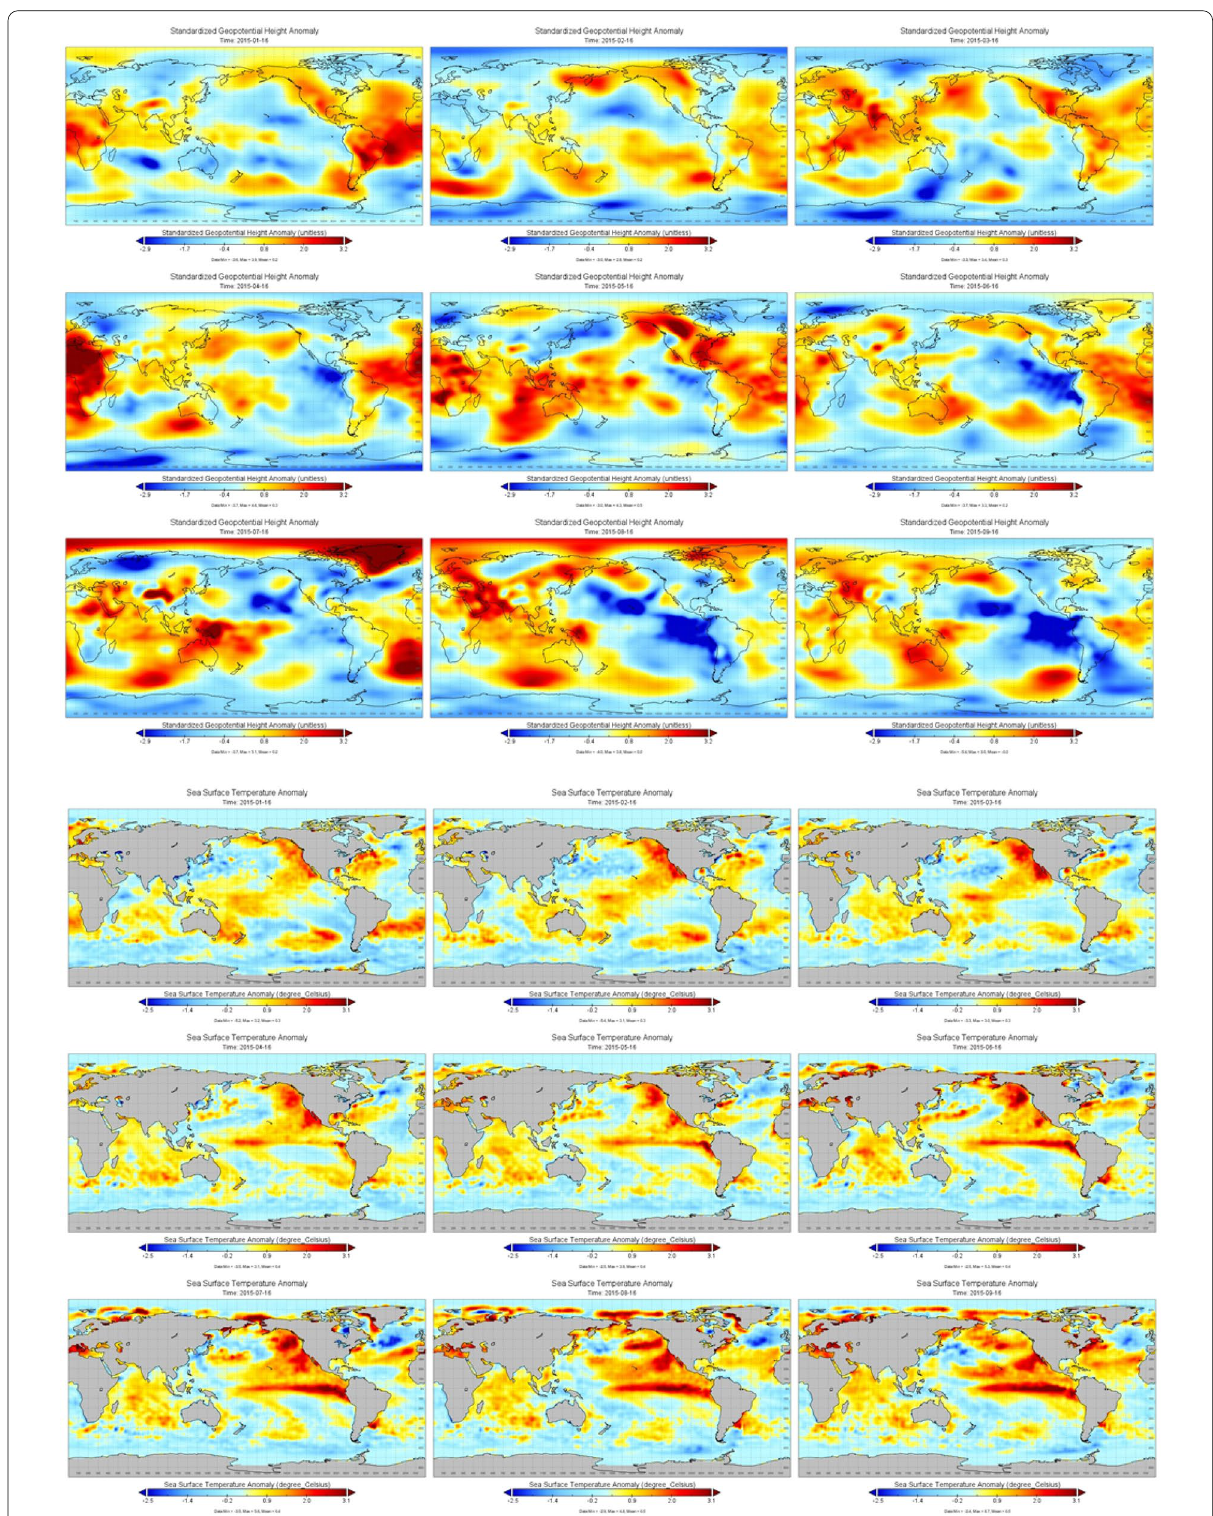
Fig. 22 Global-scale GPH and SST anomaly (January to September